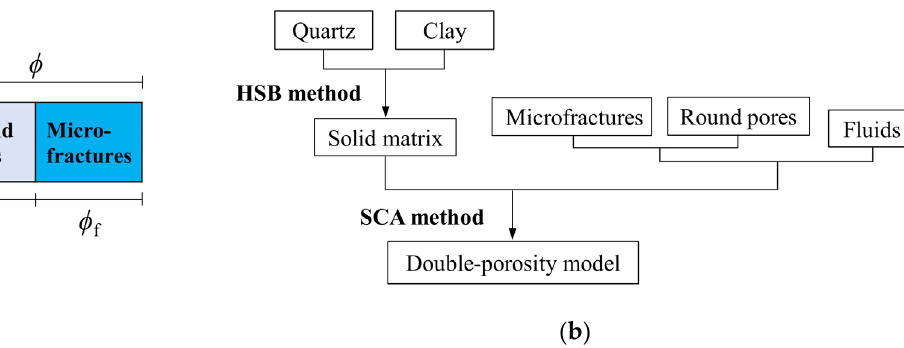
Figure 2. ( a ) Schematic illustration and ( b ) flowchart of rock physics modeling for tight sandstones.